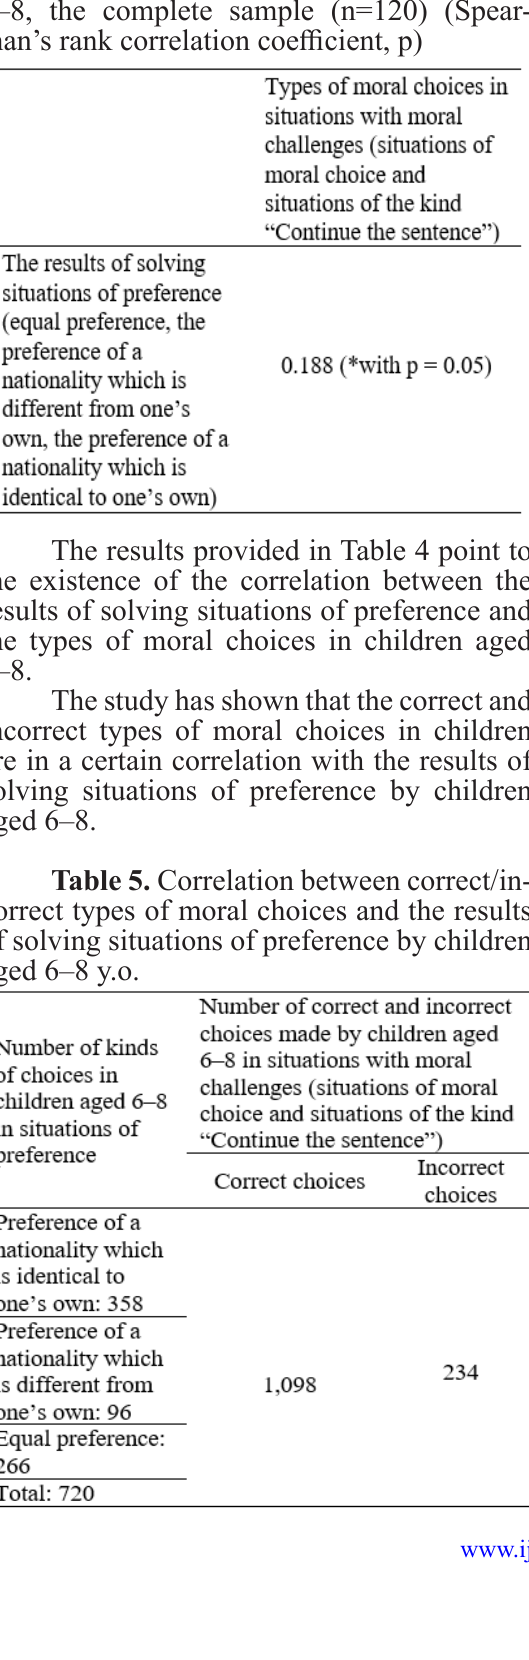
Table 4. Correlation between the results